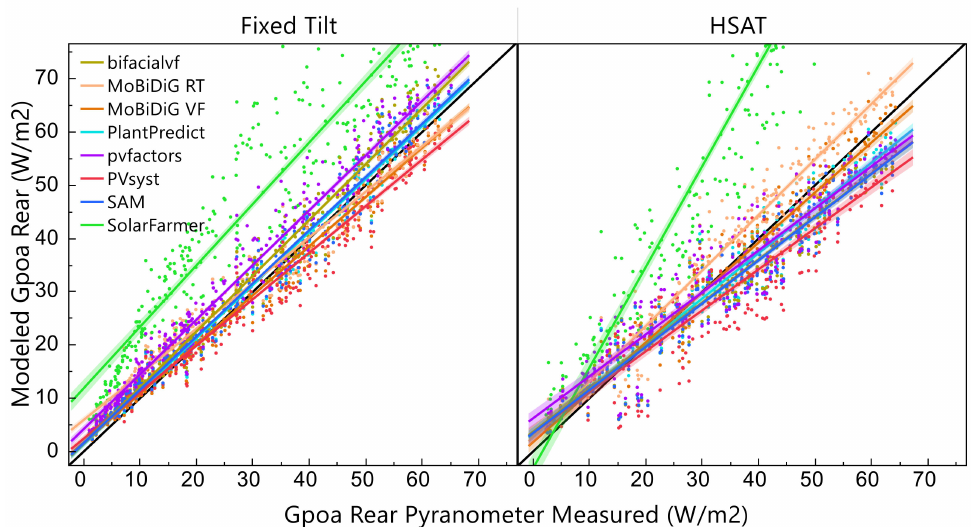
Figure 6. Simulated rear plane of array irradiance on the fixed-tilt and horizontal single-axis trackers (HSAT) systems as a function of being measured over a 5-week period. The solid black 45 ◦ line represents unity to the measurements. The measurements are the average of two pyranometers located a minimum of 12 m from the nearest array edge. The shaded areas around each regression line indicate the 95% confidence